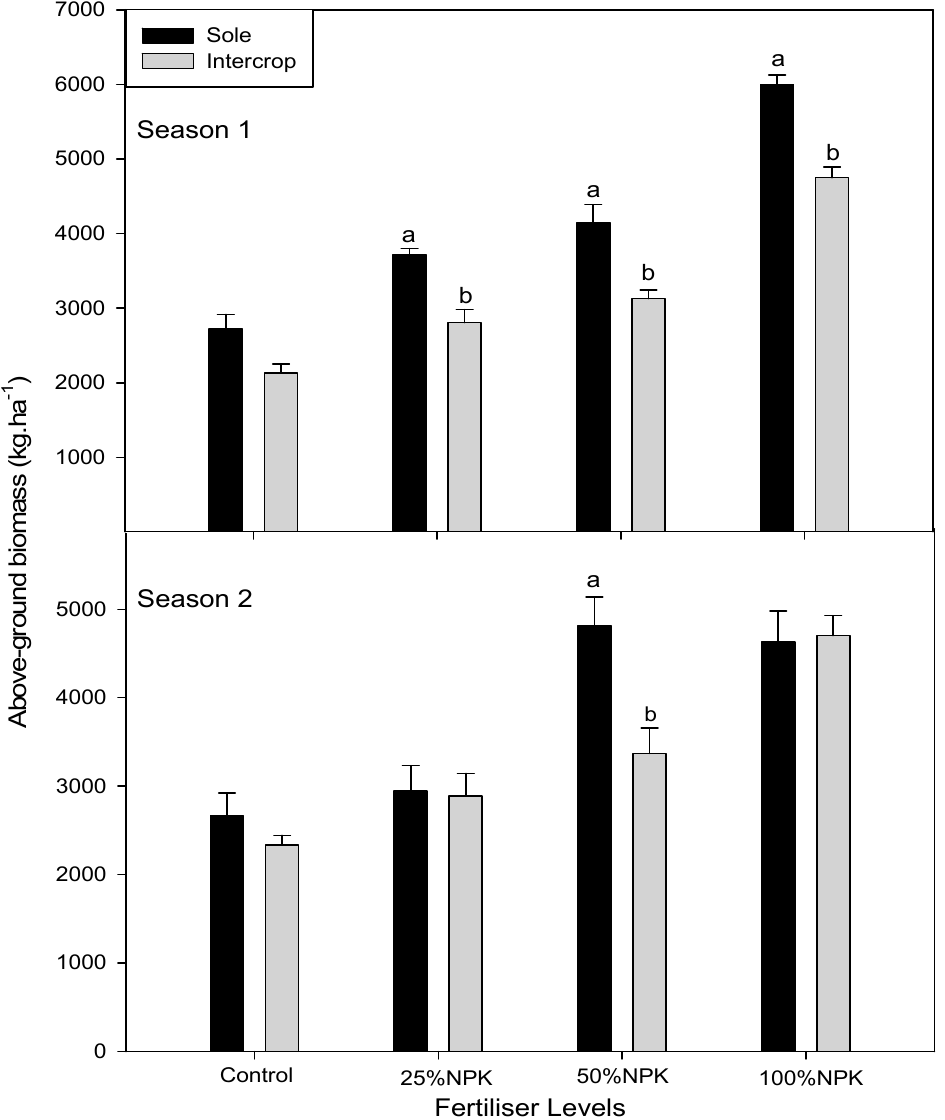
Figure 7. Two-way analysis showing the effects on ( A , B ) plant and ( C , D ) soil P concentration on rhizosphere of above ground biomass of amaranth at four NPK levels in 2014 / 15 and 2015 / 16 seasons. Each bar represents the mean ± SE (n = 4). Lettering in each fertilizer treatment shows significant differences at p ≤ 0.05 in sole or intercropping.